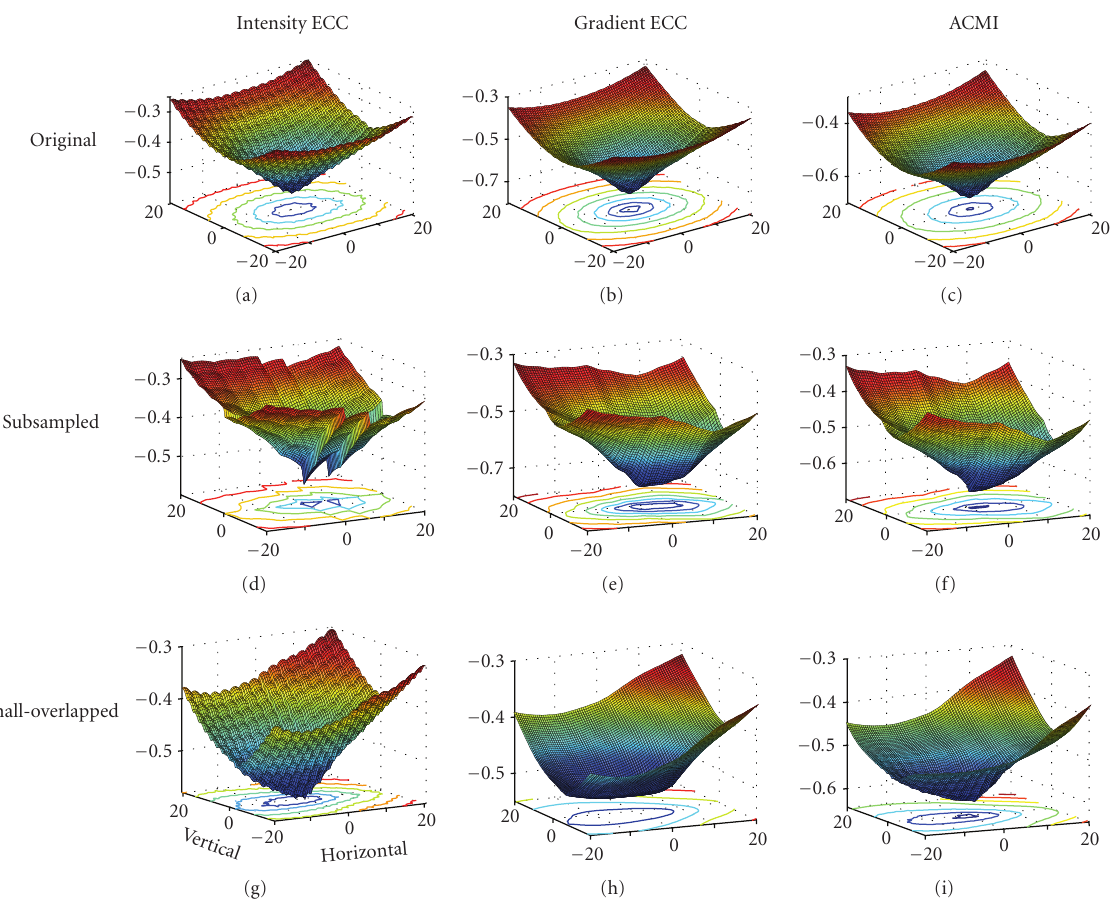
Figure 6: Registration function (PET/MRI T1) versus relative displacement between reference and floating images in horizontal and vertical orientations. For the original images, the ACMI performs slightly better than intensity and gradient ECC (top row). For the subsampled version, the intensity ECC presents a global maximum corresponding to the correct alignment, but also presents many local maxima, espe- cially a secondary maximum near the global maximum (d). The gradient ECC presents less local maxima, but a valley at the bottom (e). For small-overlapped version, the intensity ECC is strongly rough, though it presents only a global maximum corresponding to the correct alignment (g). The gradient ECC is smoother, but presents a plateau at bottom not including the correct registration point (h). ACMI of each image version provides su ffi cient smoothness in the coarse registration stage and presents only one global maximum at coordinate (0, 0) of the graph (corresponding to the correct alignment) in the fine registration stage ((c), (f), and